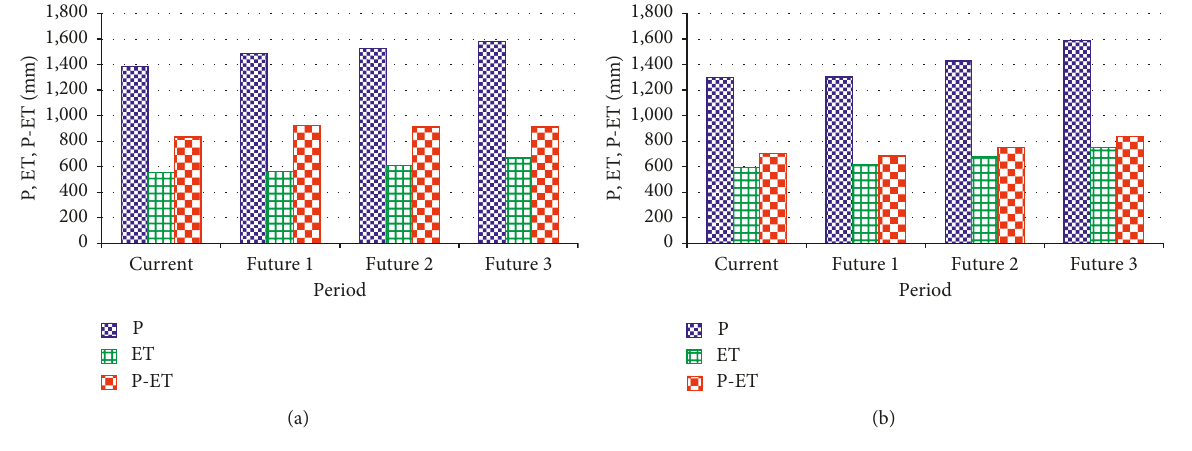
Figure 13: P, PET, and P-PET. (a) Gyeongsang-do. (b) Jeolla-do.